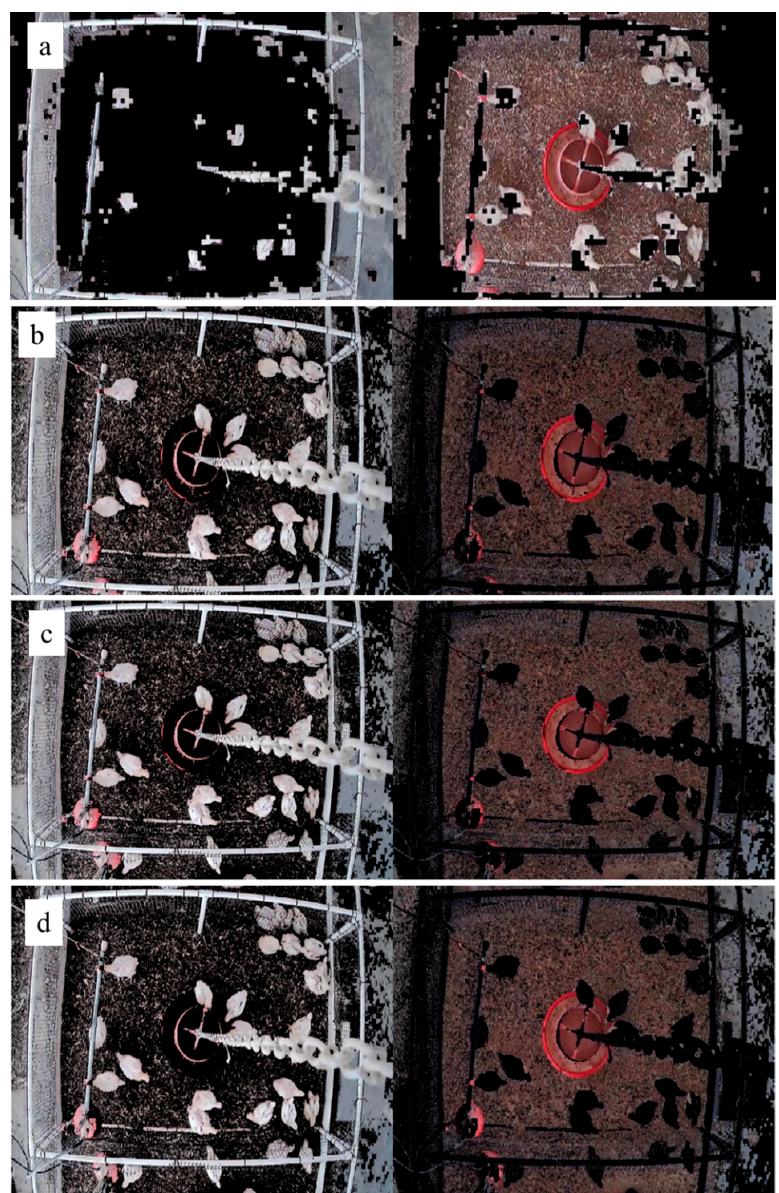
Figure 3. Comparison between different color spaces (( a ) LAB, ( b ) RG, ( c ) RB, and ( d ) GB) in the classification process.